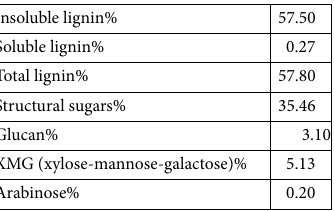
Table 3. HPLC analysis of the feedstock